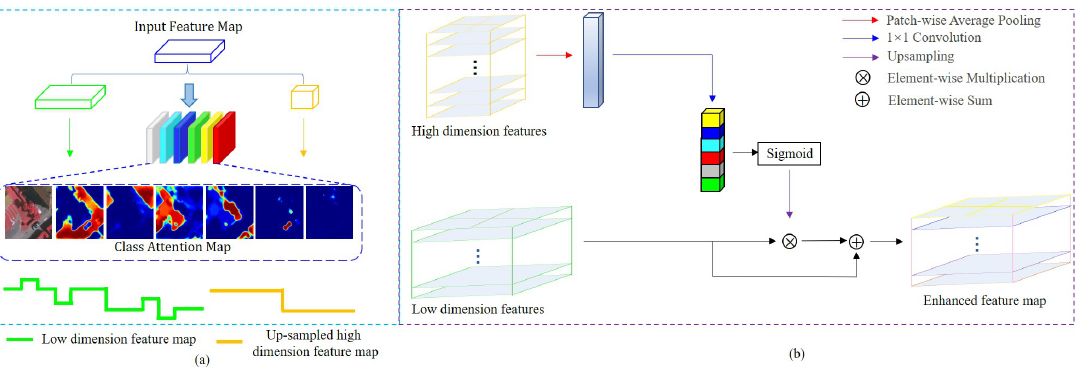
Figure 7. Design motivation and detailed structure of the PFM. ( a ) is the design motivation of PFM, and ( b ) is the specific structure of